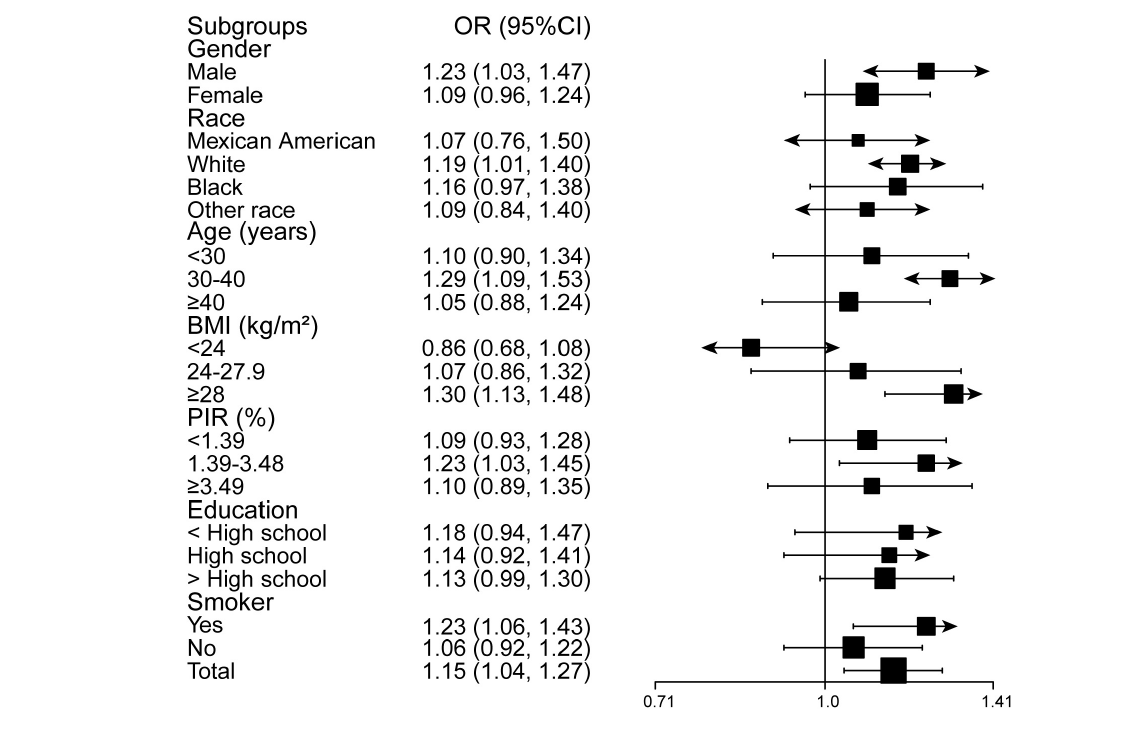
FIGURE3 Subgroups analyses of the association between HSV-2 and asthma. HSV-2, Herpes simplex virus type 2. All the covariates in Table 1 were